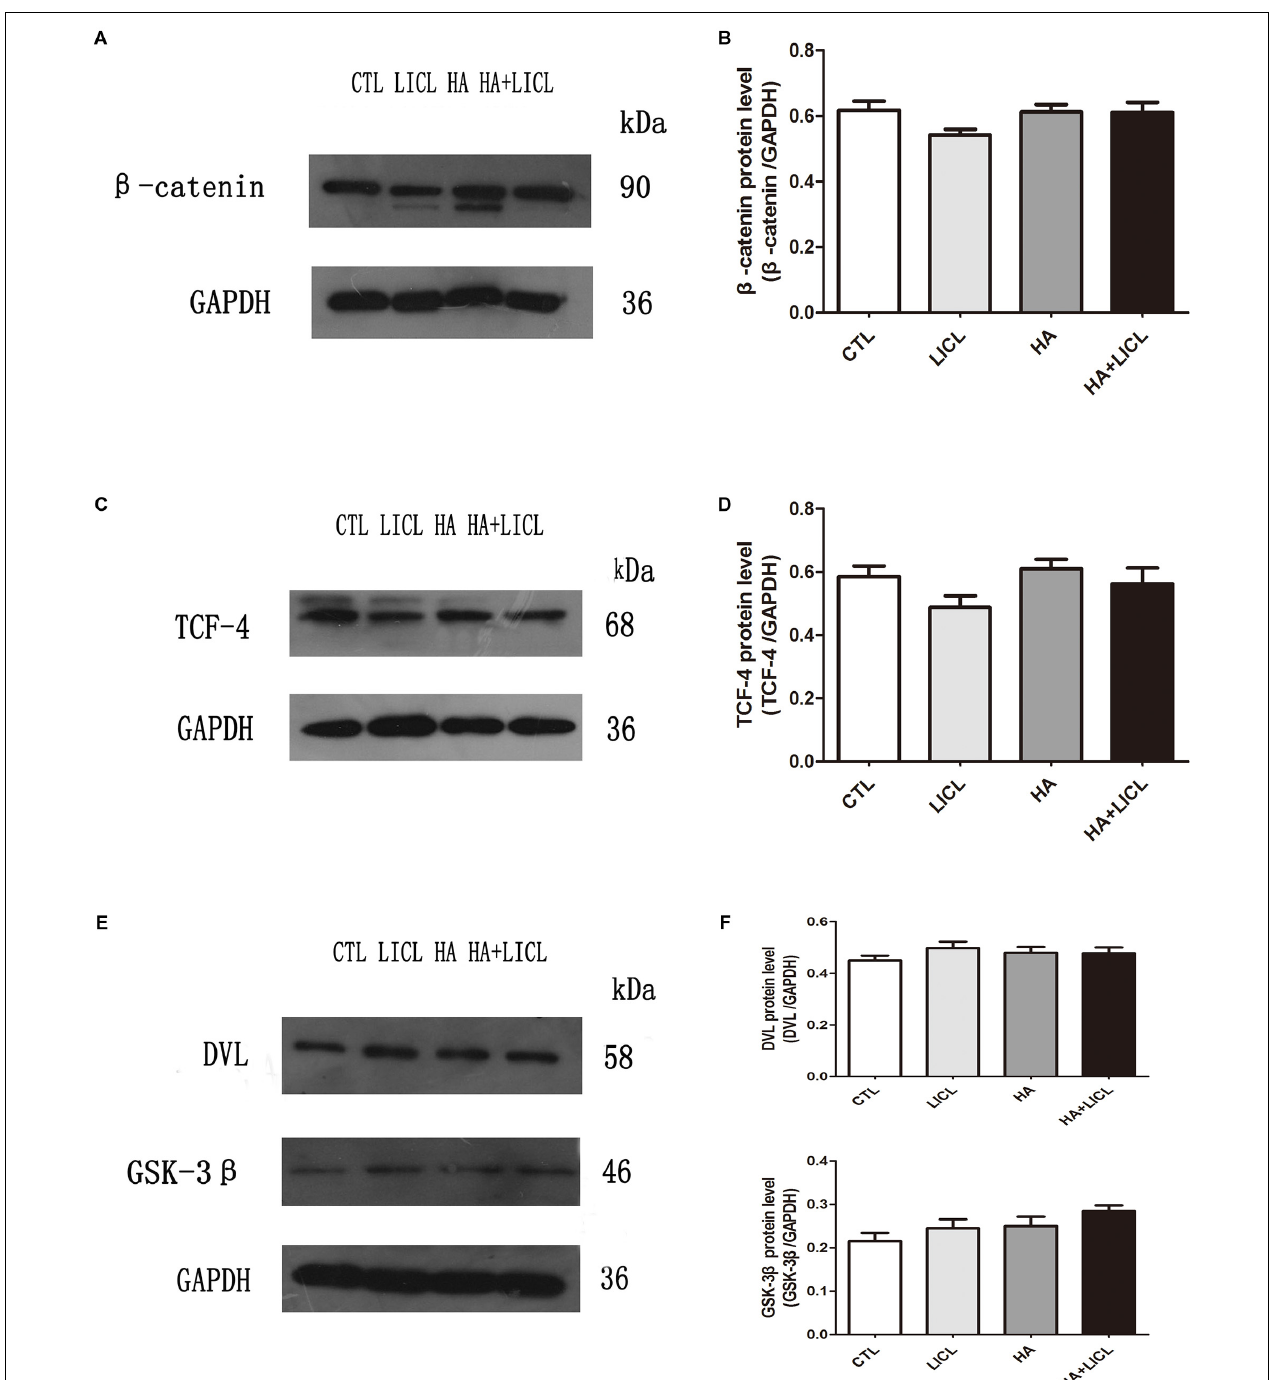
FIGURE 4 | The expression of Wnt/ β -catenin signaling pathway proteins. (A–F) After letrozole exposure there was no significant difference of β -catenin, TCF-4, GSK-3 β and DVL2 between CTL group and HA group. Furthermore, single lithium chloride or co-letrozole treatment had no effects on the expression of four proteins in LICl group and HA+LICl